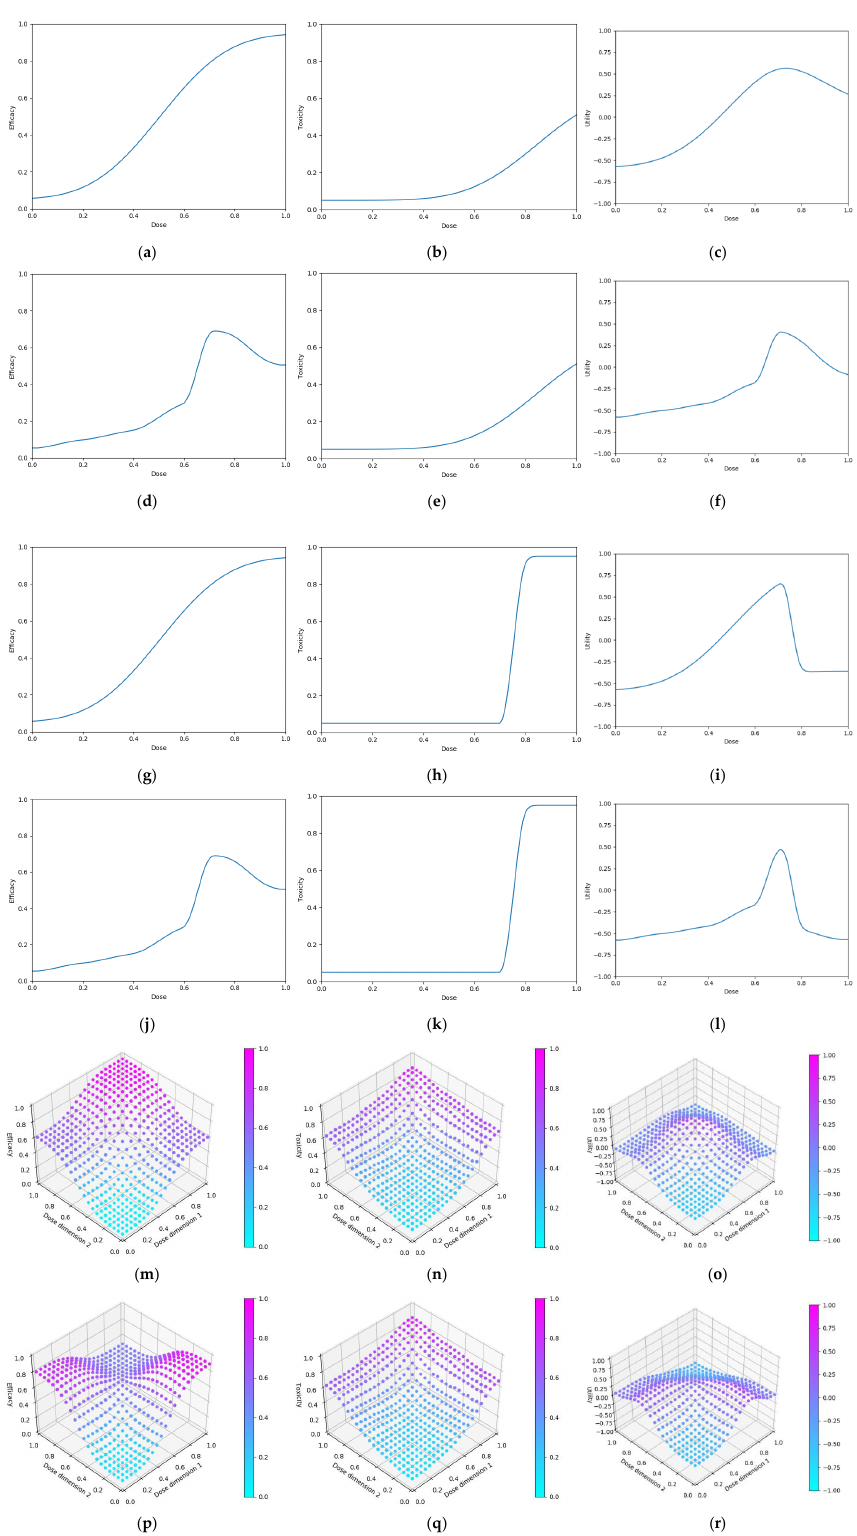
Figure 8. Dose-efficacy/toxicity/utility plots for the six objective 3 scenarios. These were ( a – c ) sce- nario 1, ( d – f ) scenario 2, ( g – i ) scenario 3, ( j – l ) scenario 4, ( m – o ) scenario 5, and ( p – r ) scenario 6. Left/middle/right plots were, respectively, for efficacy/toxicity/utility. ( a – l ) The blue line represents the probability of efficacious/toxic response and utility for each dose. ( m – o ) Purple represents areas of higher efficacy/toxicity/utility.